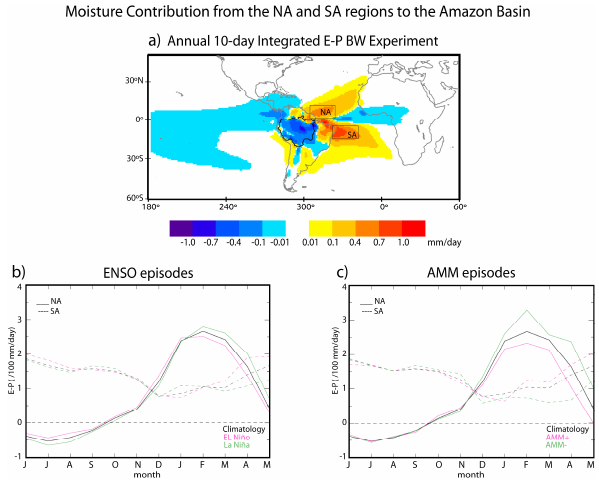
Figure 2. (a) Climatological annual average of 10-day integrated ( E − P ) obtained through the backward Amazon experiment for the period June 1979–May 2012. The black contour line indicates the basin area, and the boxes NA and SA indicate the source areas se- lected. (b) The annual cycle of the monthly values of 10-day ( E − P ) shown in Fig. 1 and integrated over the NA (continuous line) and SA (traced line) source areas indicated in (a) . Black lines represent the 33-year average values, while pink and green lines indicate the av- erage of the El Niño and La Niña events, respectively. (c) : as (b) , but the pink and green lines indicate the average of the AMM + and AMM − events,